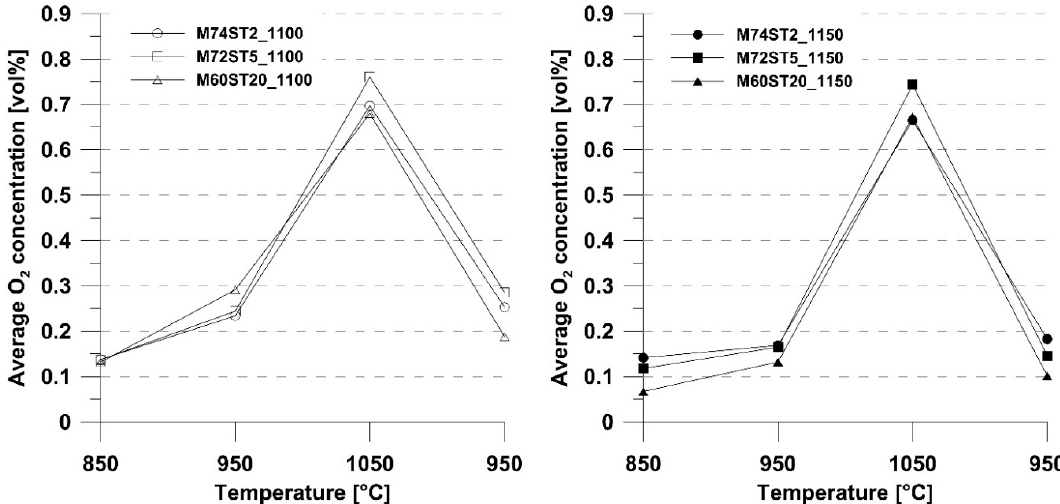
Figure 6. Average O 2 concentration during last 300 s of inert period as a function of bed temperature for materials calcined at 1100 °C (left side) and 1150 °C (right side). The straight lines between the points are only meant to increase readability and do not have a physical meaning.